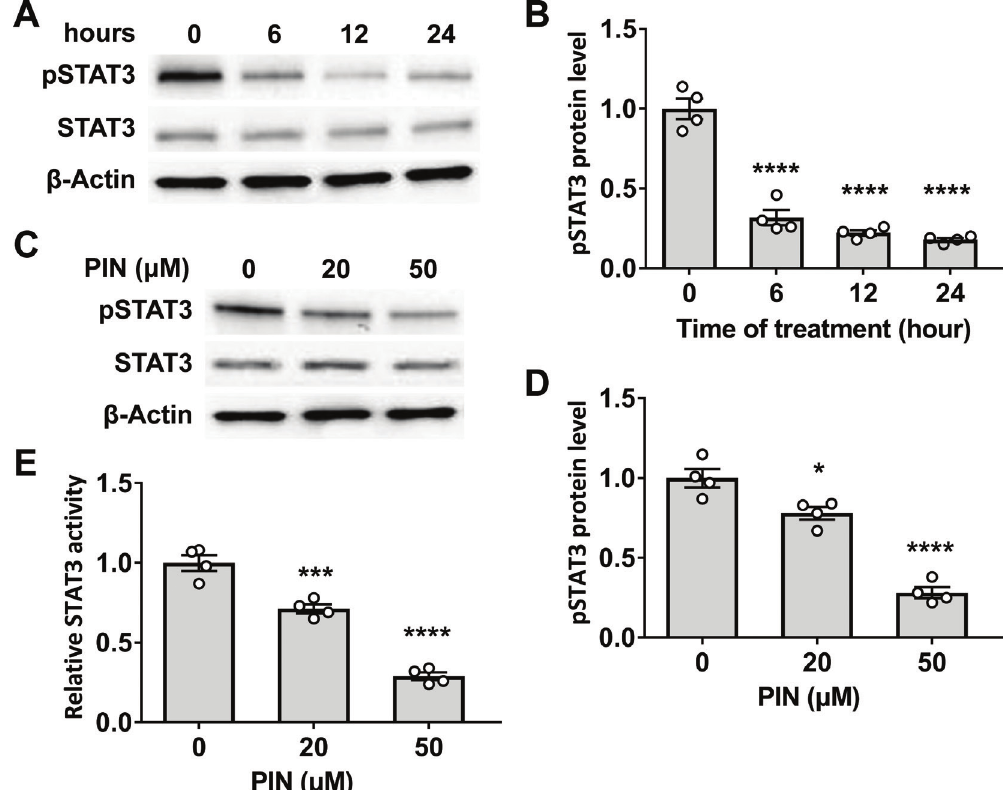
Fig. 4. Pinocembrin inhibited the activation of STAT3. (A–B) A549 cells were treated with 50 μM pinocembrin (PIN) for the indicated time, and the protein levels of pSTAT3 and STAT3 were determined by western blot. (C–E) A549 cells were treated with pinocembrin (PIN) at the indicated concentration for 12 h, and the protein levels of pSTAT3 and STAT3 were determined by western blot (C and D), and the activity of pSTAT3 was analyzed by luciferase assay (E). Four wells per group. The significant difference was analyzed using one-way ANOVA test. * P < 0.05, *** P < 0.001, **** P <